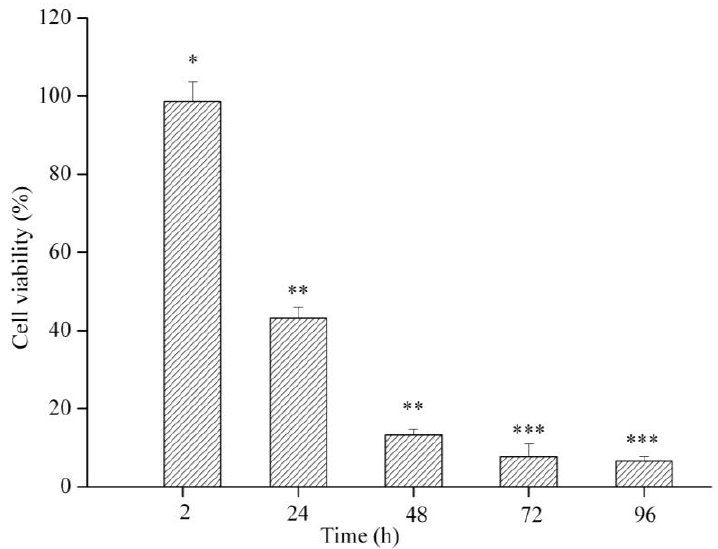
Figure 5. Cytotoxicity of DOX-loaded micelle against MCF-7 cells. The cells were incubated with DOX-loaded micelle (DOX concentration 10 µg/mL) for 2, 24, 48, 72 and 96 h at 37 °C. Each bar represents the mean of five measurements ± S.D. Bar marked with * ( p = 0.89) showed no significant difference between 2 h incubation and control. Bars marked with ** ( p < 0.001) showed significant difference between 2 h and 24 h and 48